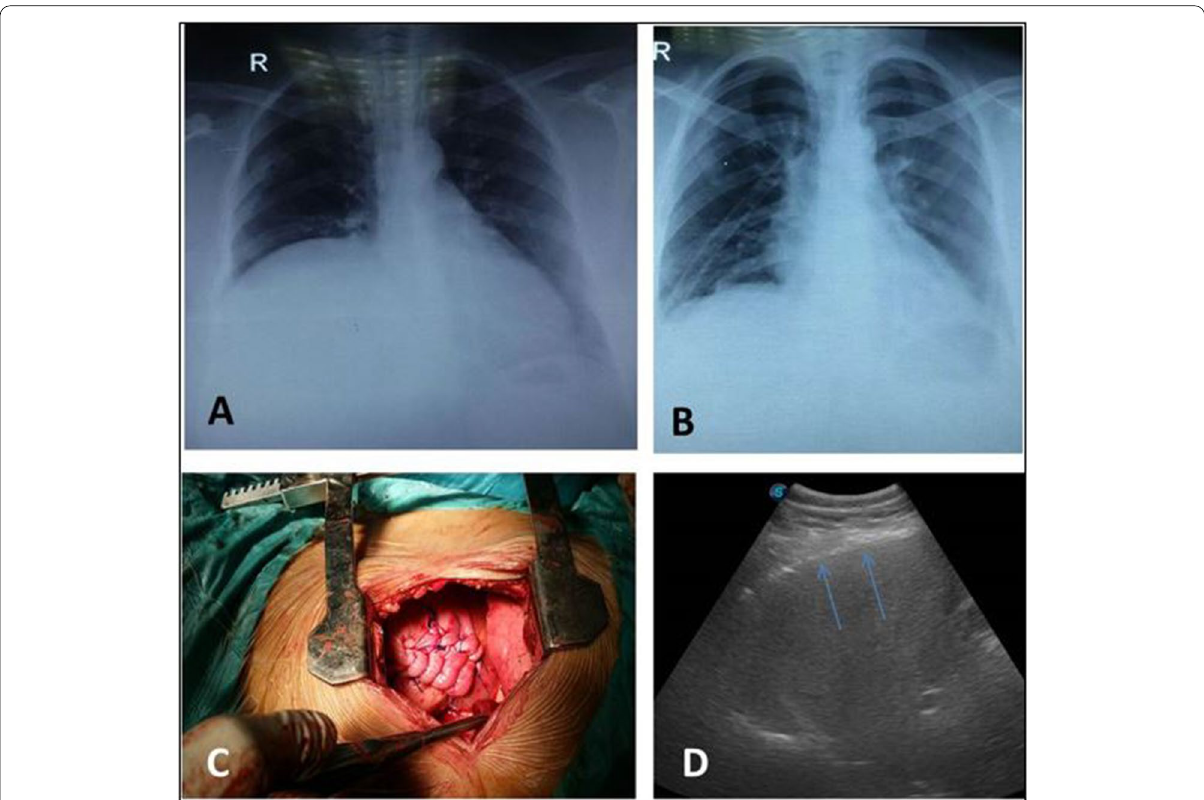
Fig. 1 Female patient 38 years old with right diaphragmatic paralysis: A Pre‑operative CXR showing significant right diaphragmatic paralysis. B Post‑operative CXR with an intercostal tube. C Intraoperative photograph after the end of plication. D Post‑operative DUS image showing the right diaphragm (arrows)